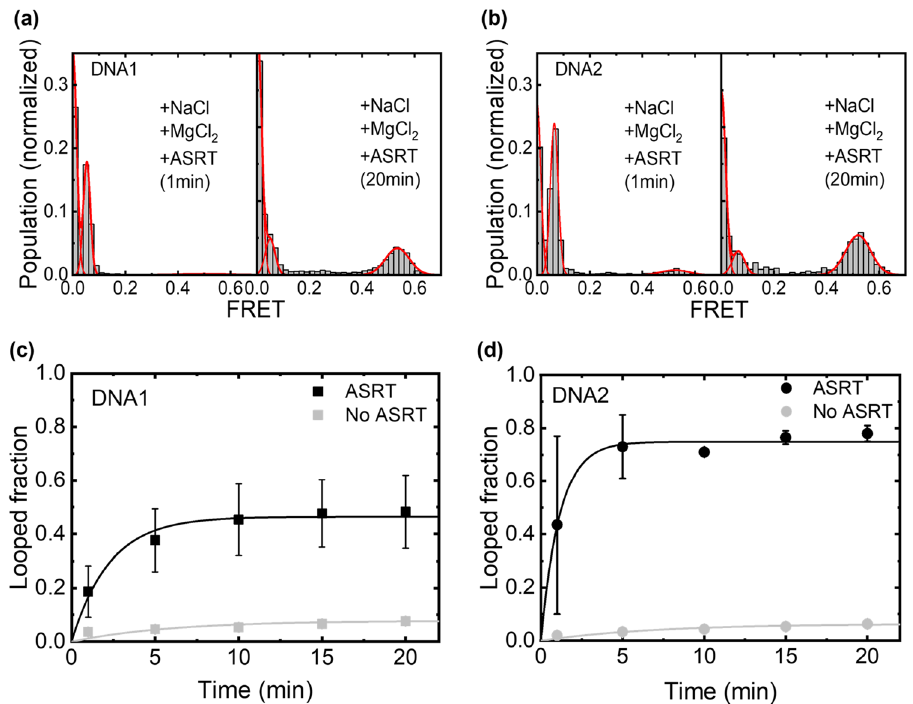
Figure 3. Single-molecule FRET histograms in the presence of ASRT with ( a ) DNA1 and ( b ) DNA2. Data obtained (left) right after- and (right) 20 min after injection of buffer containing ASRT, 10 mM MgCl 2 and 50 mM NaCl. ( c , d ) The fraction of the looped DNA molecules obtained from the FRET distributions. ( c ) for DNA1 and ( d ) for DNA2.